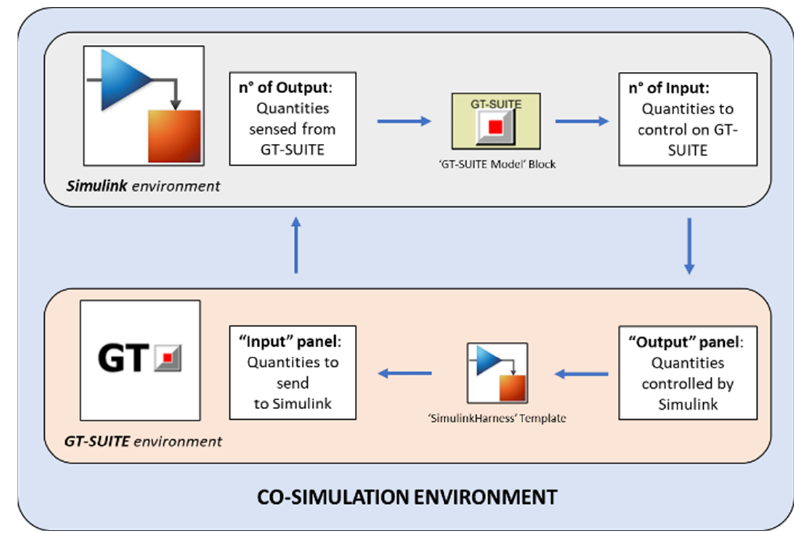
Figure 2. Illustrative scheme of GT-SUITE/Simulink coupling mechanism.